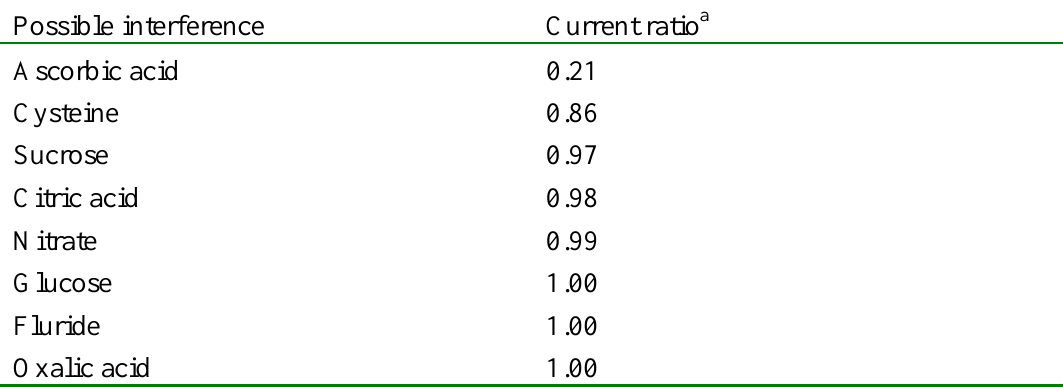
Table 1. Possible interferences tested with the enzyme